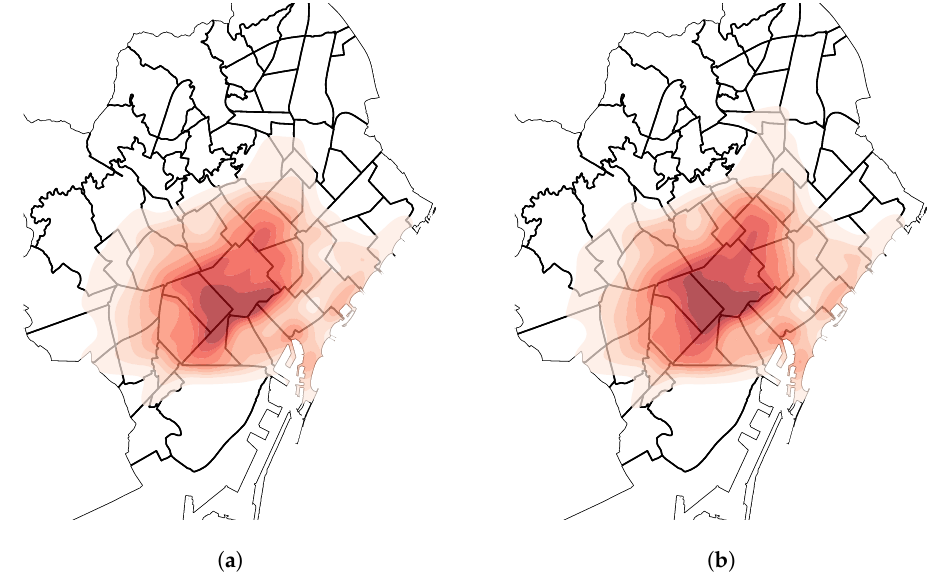
Figure 4. Location heat maps over the data set: ( a ) Starting points density; ( b ) Finishing points